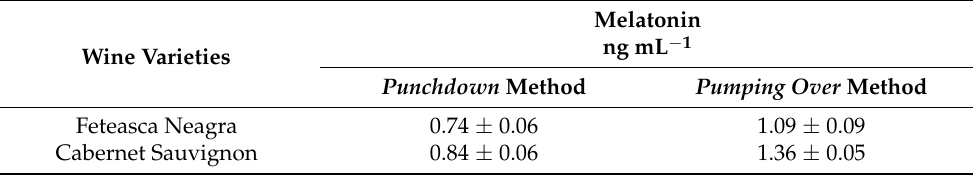
Table 5. The melatonin values obtained by the proposed DLLME-HPLC-FL method from two red wines. Melatonin Wine Varieties Punchdown Method Pumping Over